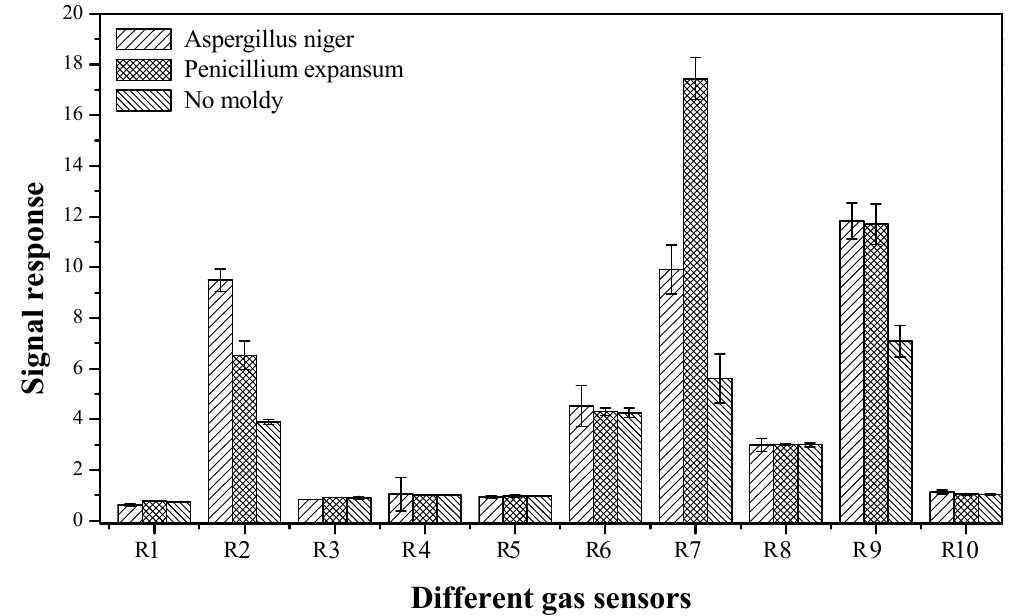
Figure 4. The gas sensors responses of the PEN3 electronic nose to apples inoculated with different molds.